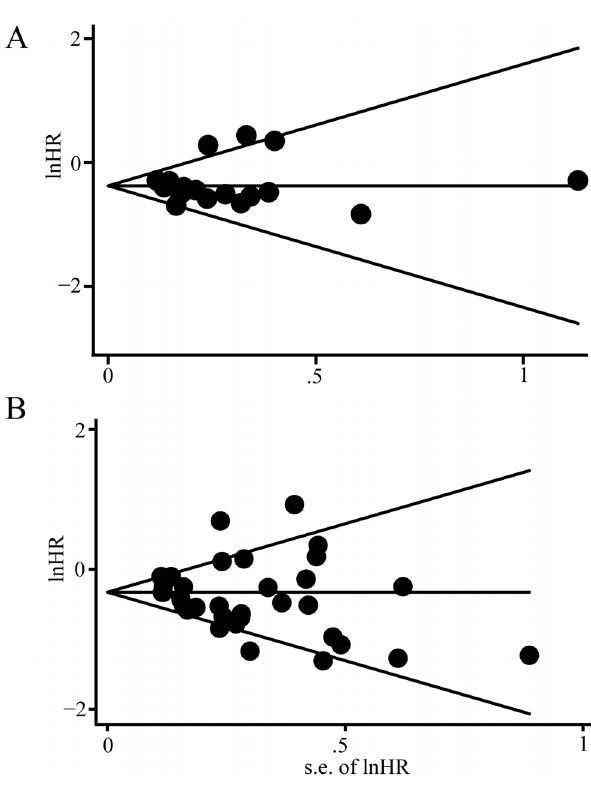
Figure 5. Begg’s funnel plots of the natural logarithm of the hazard ratios (HRs) and the SE of the natural logarithm of the HRs for all of the included studies reported with OS and PFS. A: Begg’s funnel plots for all of the included studies reported with OS, the dashed line represents 95% confidence intervals (CIs). Circles represent individual studies. Begg’s test: P =0.221. B: Begg’s funnel plots for all of the included studies reported with PFS, the dashed line represents 95% confidence intervals (CIs). Circles represent individual studies. Begg’s test: P =0.880.